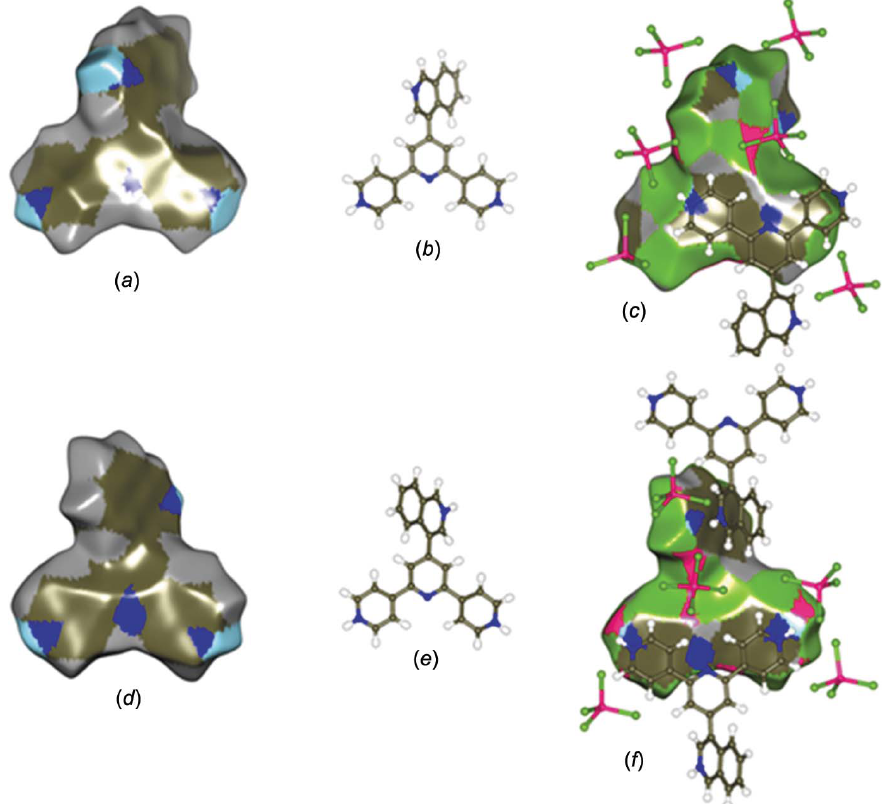
Figure 6 Hirshfeld surface of the (44TPH 3 ) 3+ cation coloured in accordance with the species contributing most to the electron density on the surface, showing ( a )/ ( c ) front and ( d )/( f ) back. In ( a )/( d ) the surface is coloured according to the interior atoms and in ( c )/( f ) the surface is coloured according to the exterior atoms. The orientation of the structure inside the surface is shown in ( b )/( e ). Colour key: H C grey, H N light blue, C dark brown, N blue, Cl green and Zn